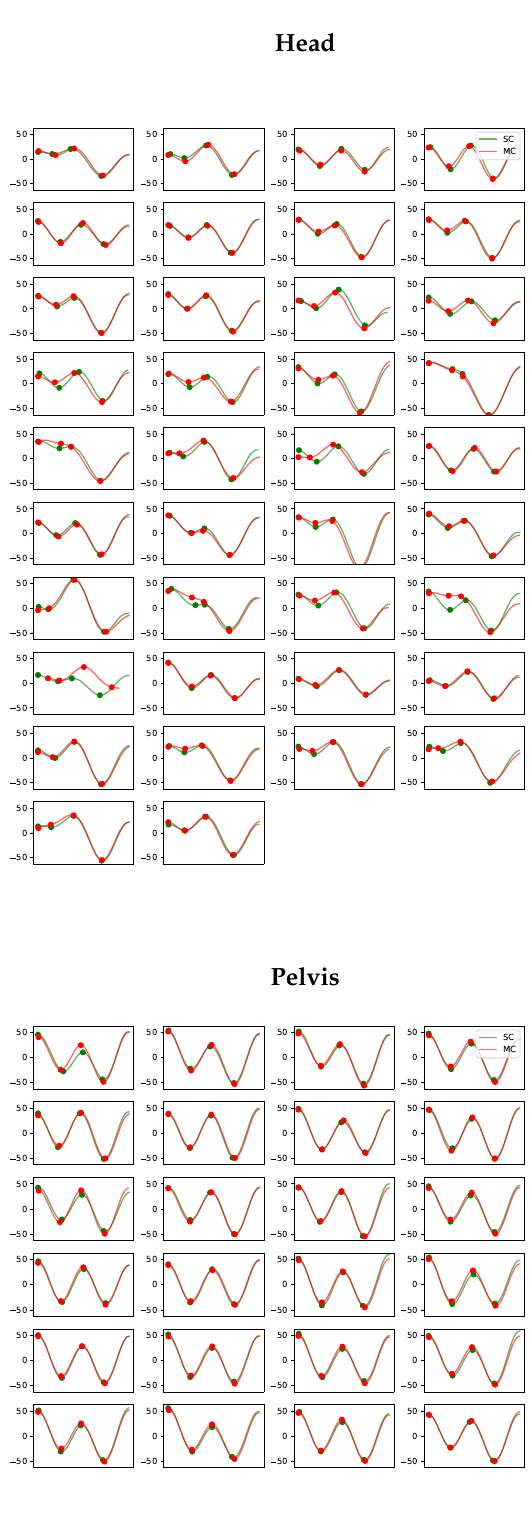
Figure A4. Vertical displacement signals per stride for the head and pelvis for horse 4. Each subplot contains the matched stride segments forthe single-camera markerless system (SC) in green and the multi-camera marker-based system (MC) in red. The y-axis shows the vertical displacement in millimeters. The four dots on each curve indicate the positions of the two peaks and two valleys extracted using the approach in Section